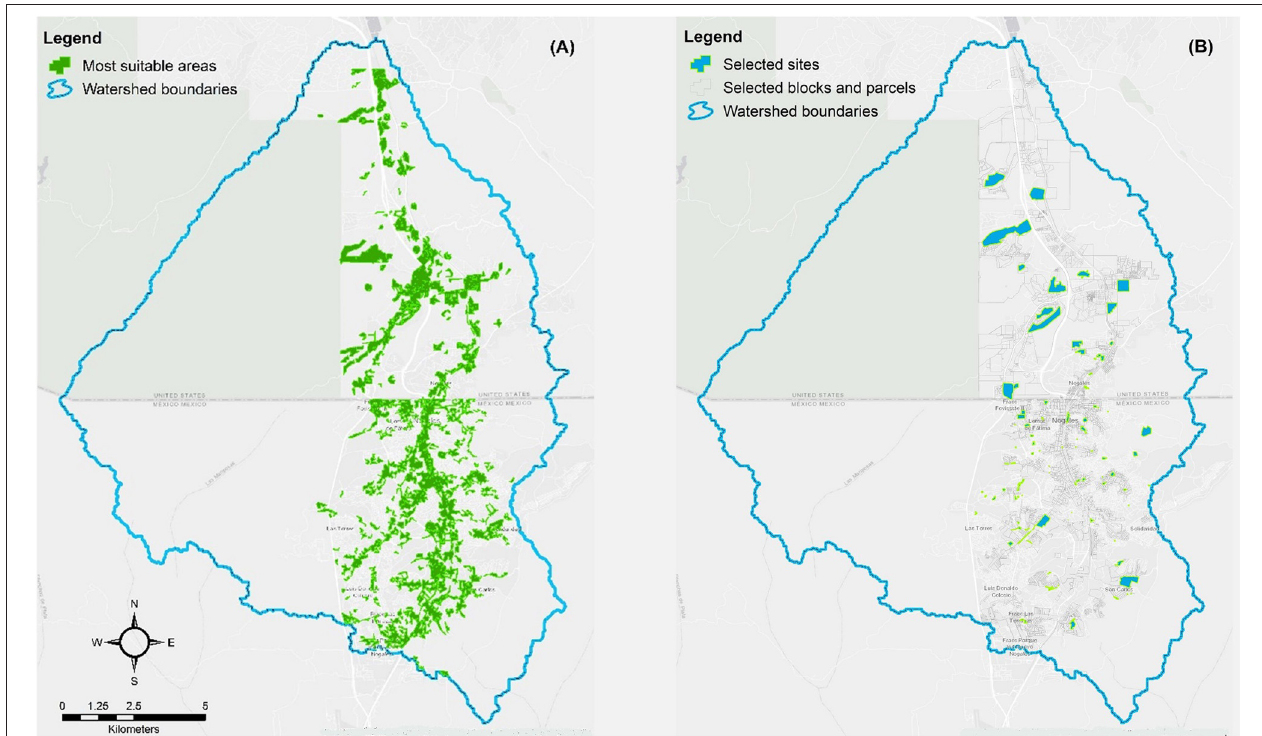
FIGURE 4 | LSA outcomes: (A) most suitable areas for UGI in the watershed. (B) Ambos Nogales UGI network selected parcels and sites.